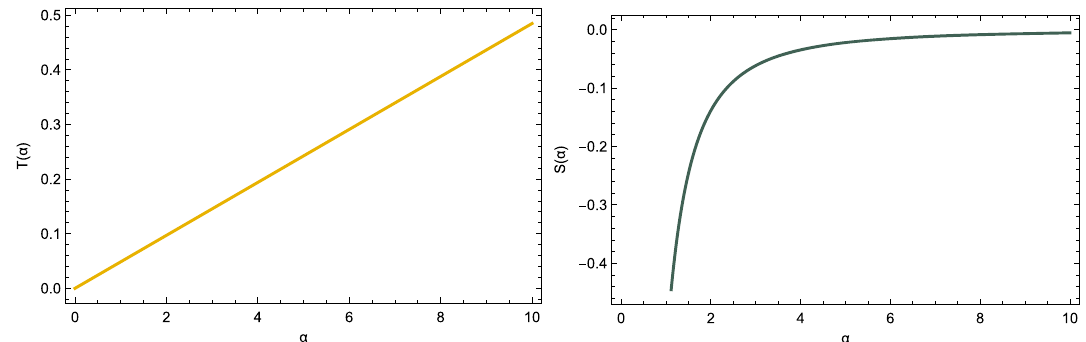
Fig. 5 The Hawking temperature T ( r + ) (left) and the Bekenstein–Hawking entropy S ( r + ) (right) at the event horizon of the black hole as functions of the modified gravity parameter α